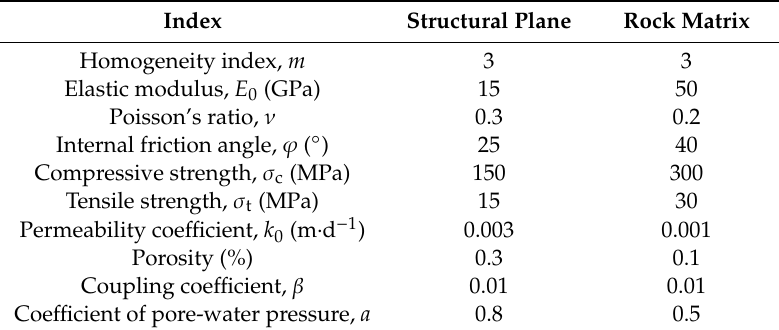
Table 1. Mean material mechanical properties for the numerical